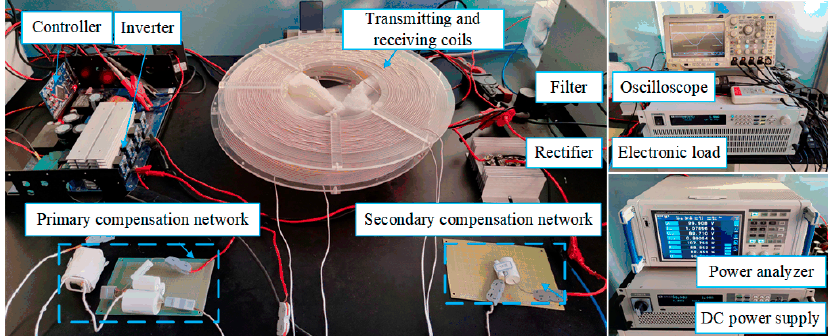
Figure 10. Prototype of the proposed LCC-S-compensated system. Table 3. Parameters of designed and experimental prototype.